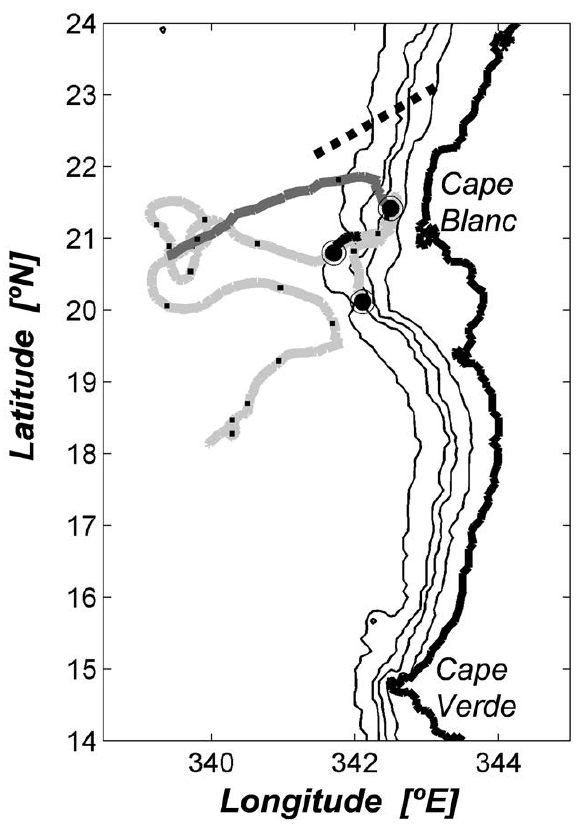
F ig . 9. – Trajectories of three buoys dragged at 100 m and deployed near Cape Blanc during the cruise. The black circles indicate the deployment positions; the black trajectory corresponds to 9 days, the dark-grey trajectory to 22 days and the light-grey trajectory to 170 days. The tick marks in the light-grey and dark-grey trajectories indicate the position every week. The thick dotted line indicates the approximate position of the CVFZ as inferred from the location of the 36.0 isohaline at 100 m (Zenk el at .